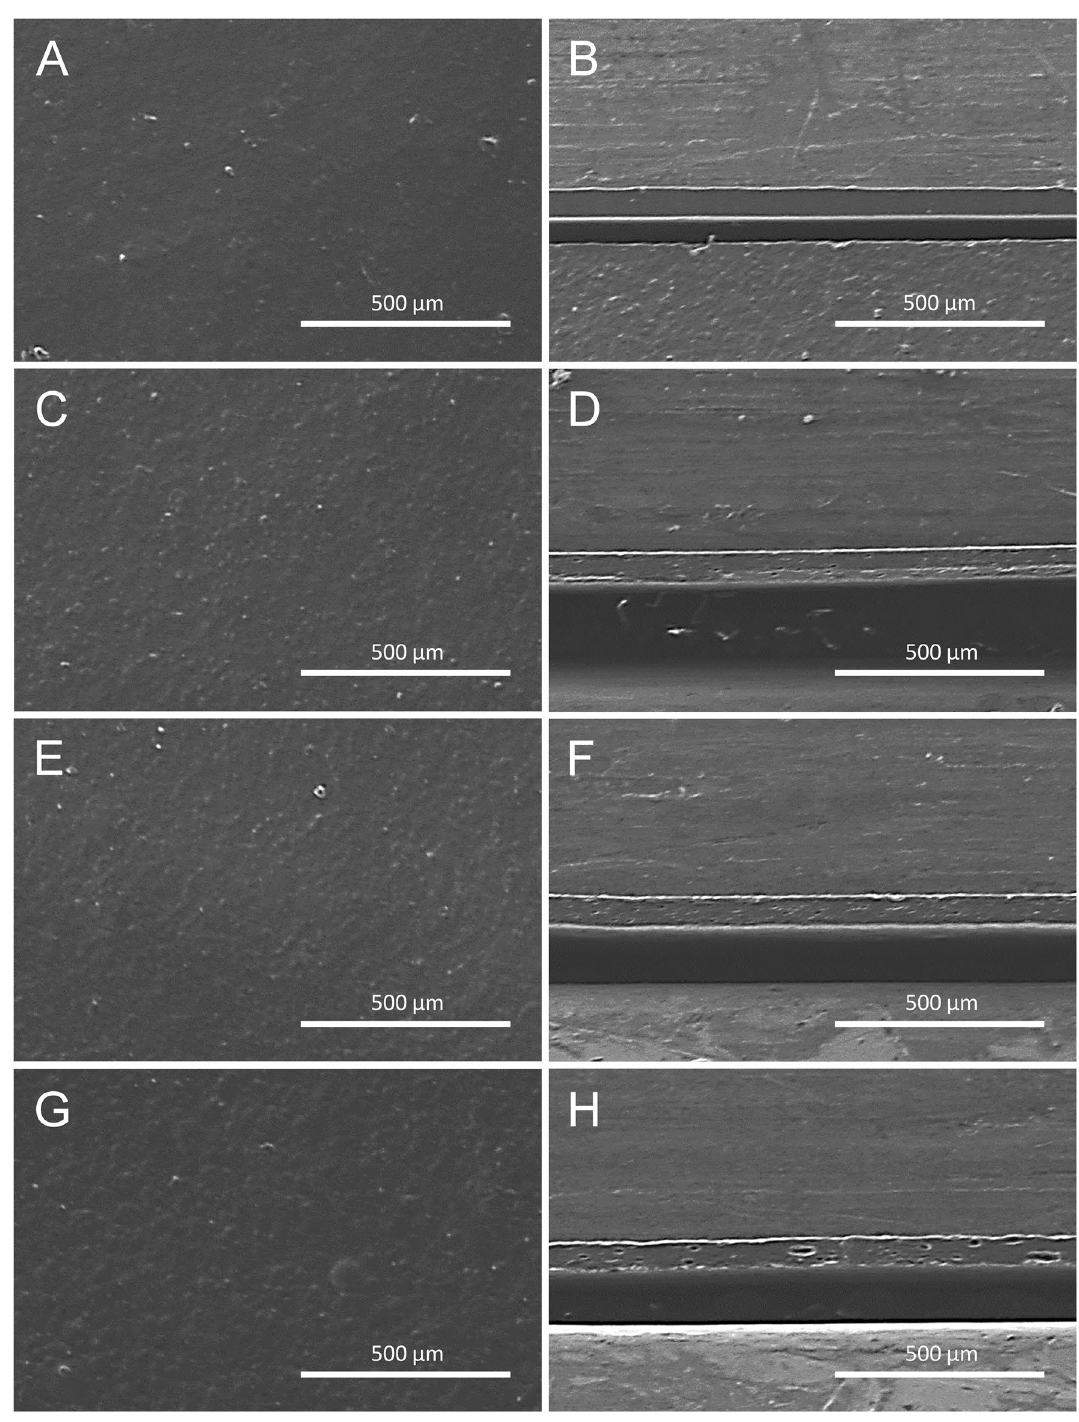
Figure 4. Morphology of GG/MBS and SSO/GG/MBS composite films. ( A , C , E , G ) Surface SEM images of GG/ MBS, 0.5% SSO/GG/MBS, 1% SSO/GG/MBS, and 0.5% SSO/GG/MBS, respectively; ( B , D , F , H ) cross-sectional SEM images of GG/MBS, 0.5% SSO/GG/MBS, 1% SSO/GG/MBS, and 0.5% SSO/GG/MBS, respectively. Scale bar is 500 μm. GG guar gum, MBS mung bean starch, SSO sunflower seed SSO was compact, homogeneous, continuous, and without pores. Therefore, the GG/MBS film had superior TS and EB values. In contrast, the SSO/GG/MBS composite films exhibited a rough surface and heterogeneous film structure caused by the addition of SSO. The roughness and heterogeneity of the film increased with the increasing concentration of SSO. As shown in SEM images of 0.5% SSO/GG/MBS (Fig. 4C,D) and 1% SSO/GG/ MBS (Fig. 4E,F) films, the droplet size was relatively small until the addition of 1% SSO to the GG/MBS films. These results indicate that the SSO was well dispersed in the film matrix. However, the 2% SSO/GG/MBS film